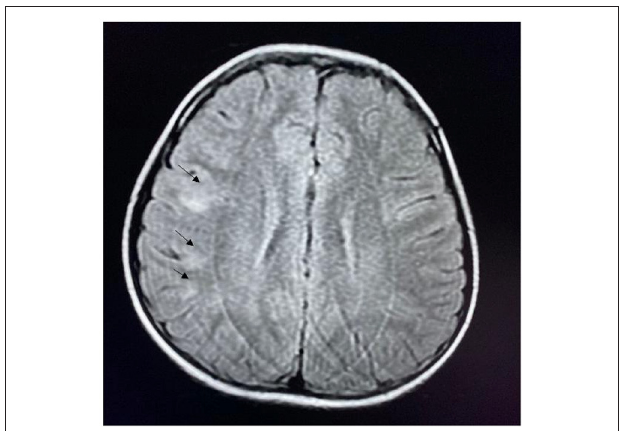
FIGURE 2 | MRI of a patient with anti-NMDAR encephalitis showing lesions in the frontal and parietal cortex (arrow).